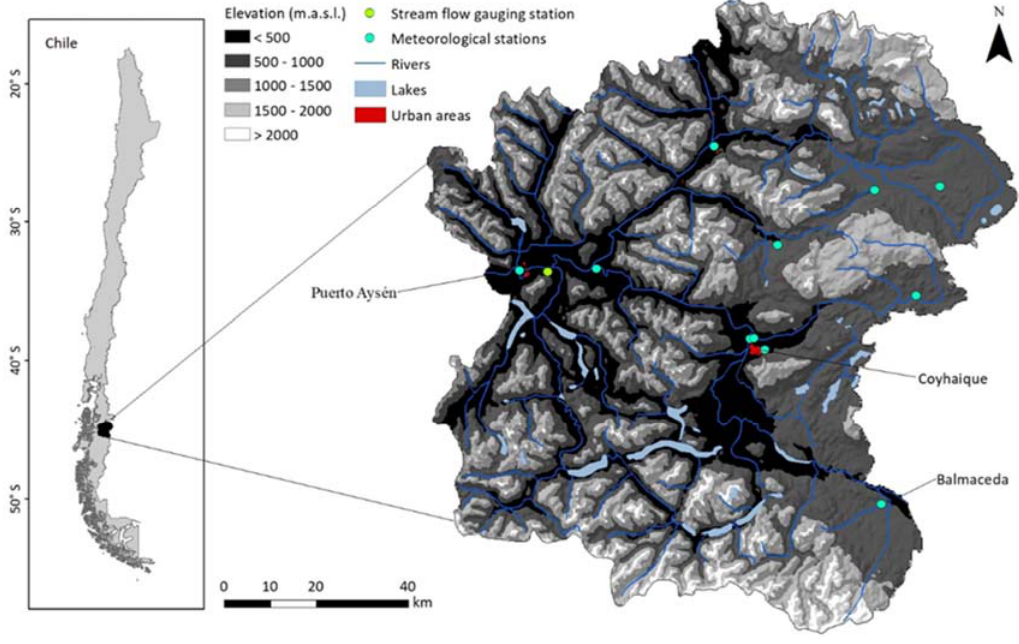
Figure 1. Aysén river catchment. Figure 1. Ays é n river catchment.